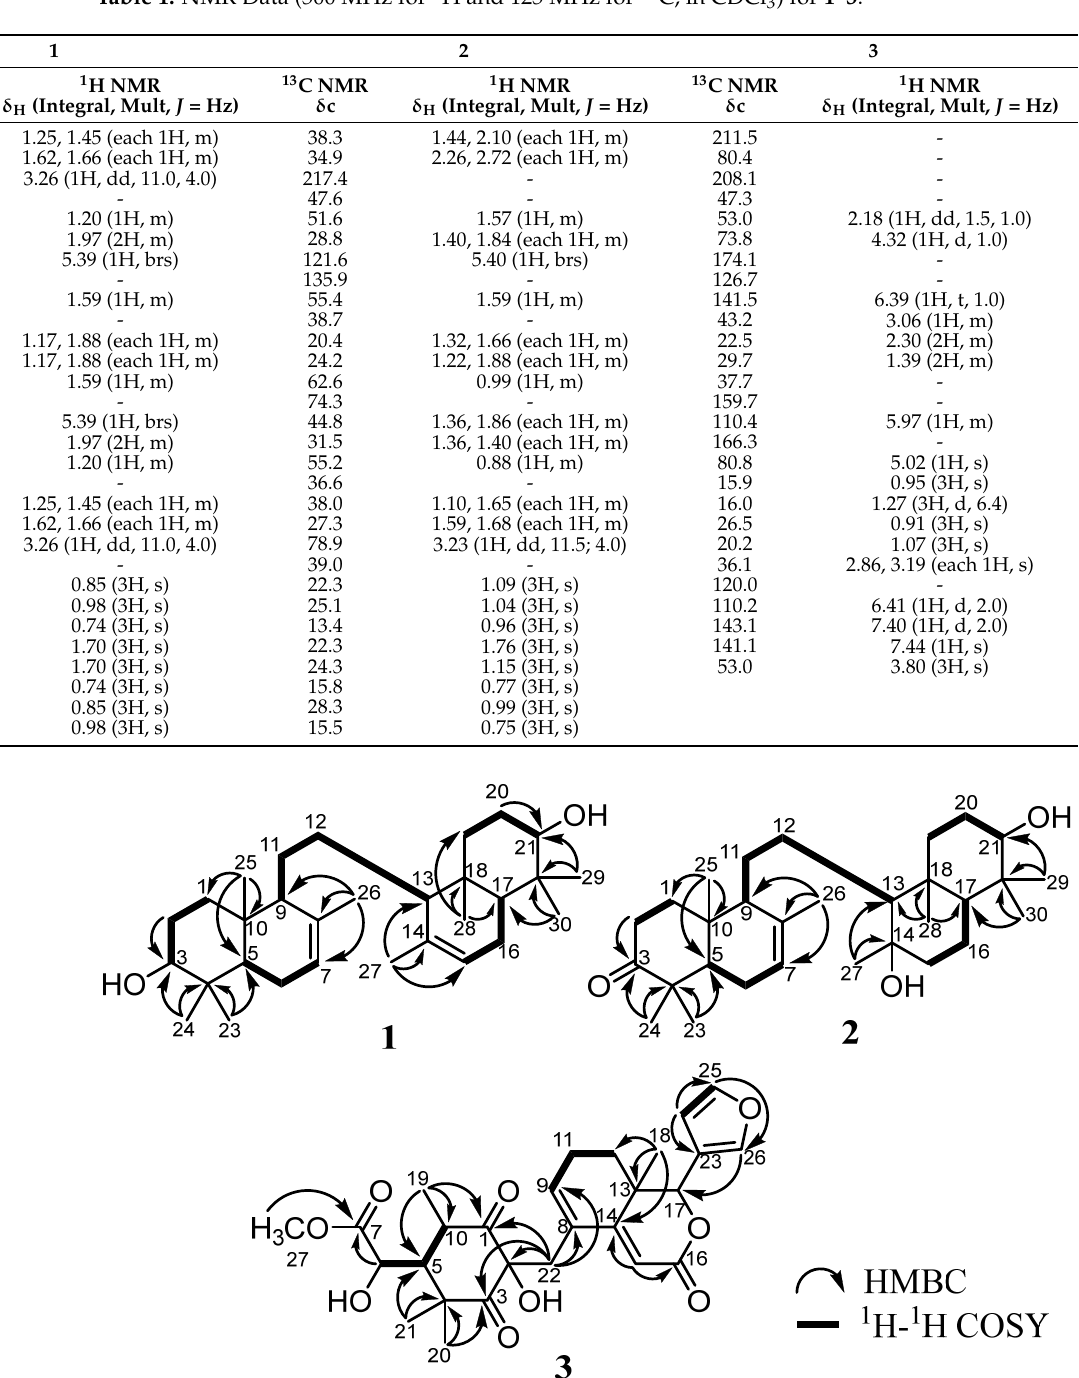
Table 1. NMR Data (500 MHz for 1 H and 125 MHz for 13 C, in CDCl 3 ) for 1–3 .